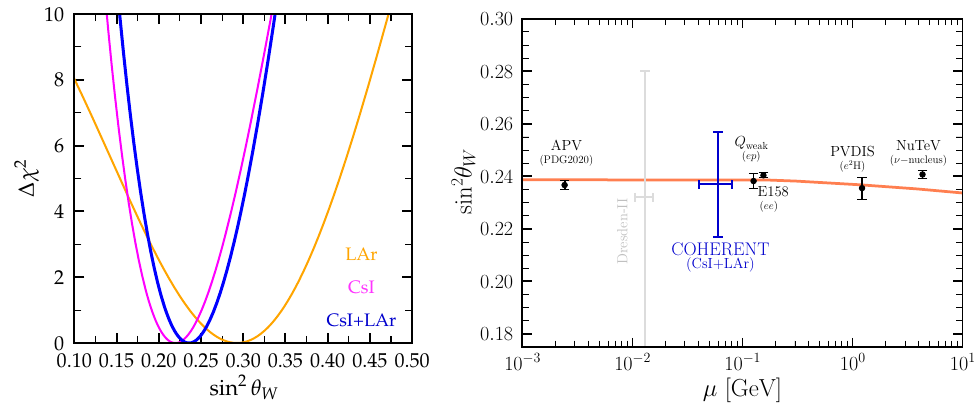
RGE running in the SM for the MS W